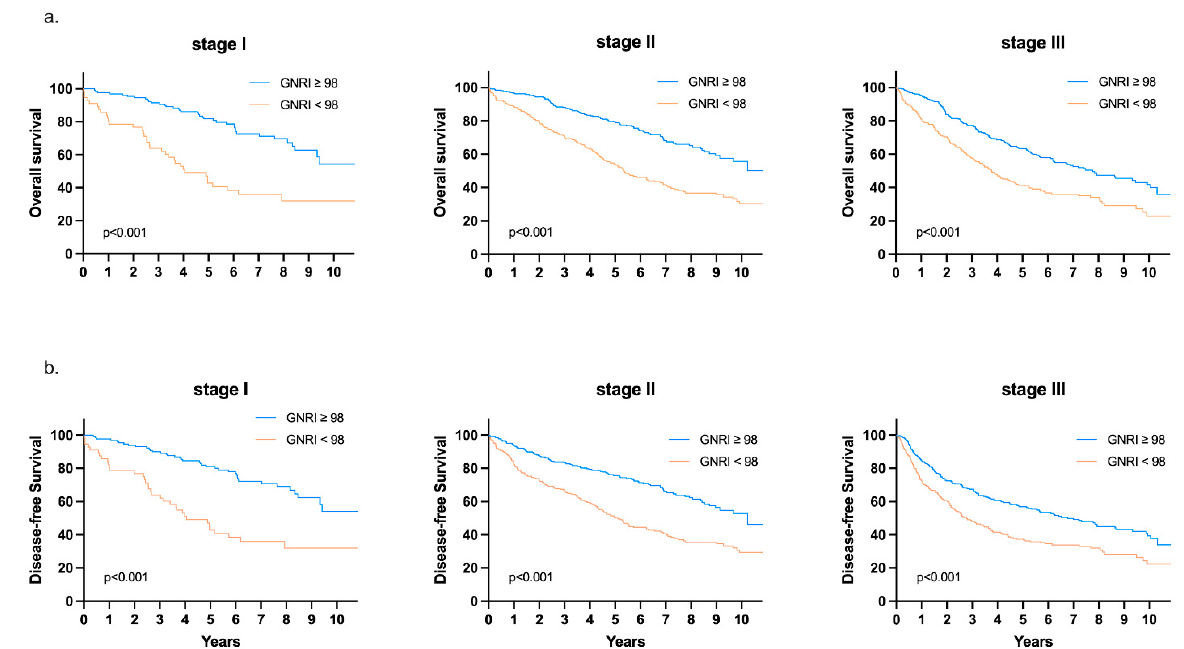
Figure 5. Kaplan–Meier survival analysis of ( a ) OS and ( b ) DFS according to GNRI in stage I, II, and III patients.